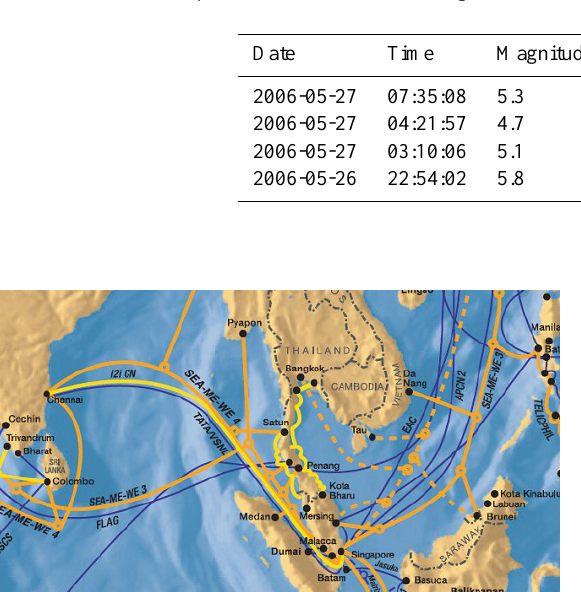
Table 1. Relevant Earthquakes in the Indian Ocean region from 26 to 27 May.